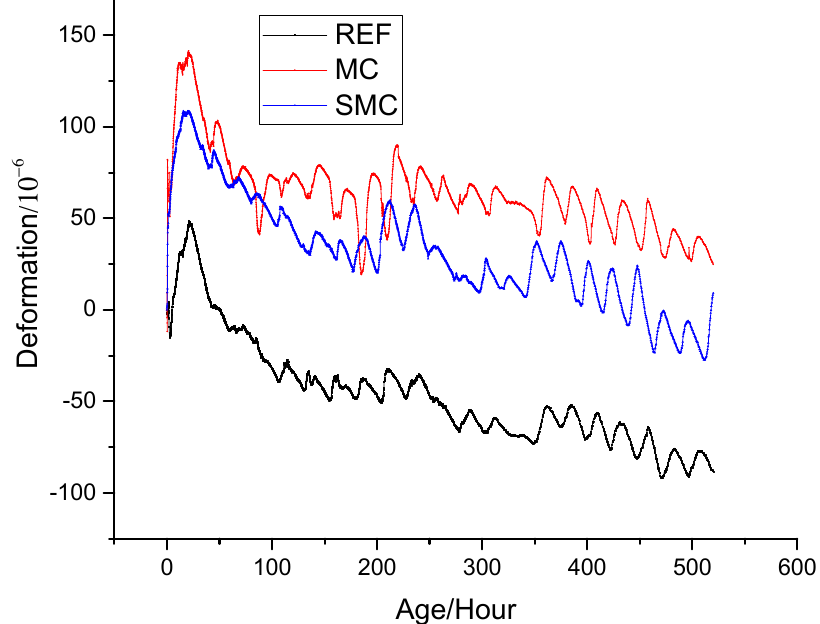
Figure 9. Deformation of concrete with different mix proportions.